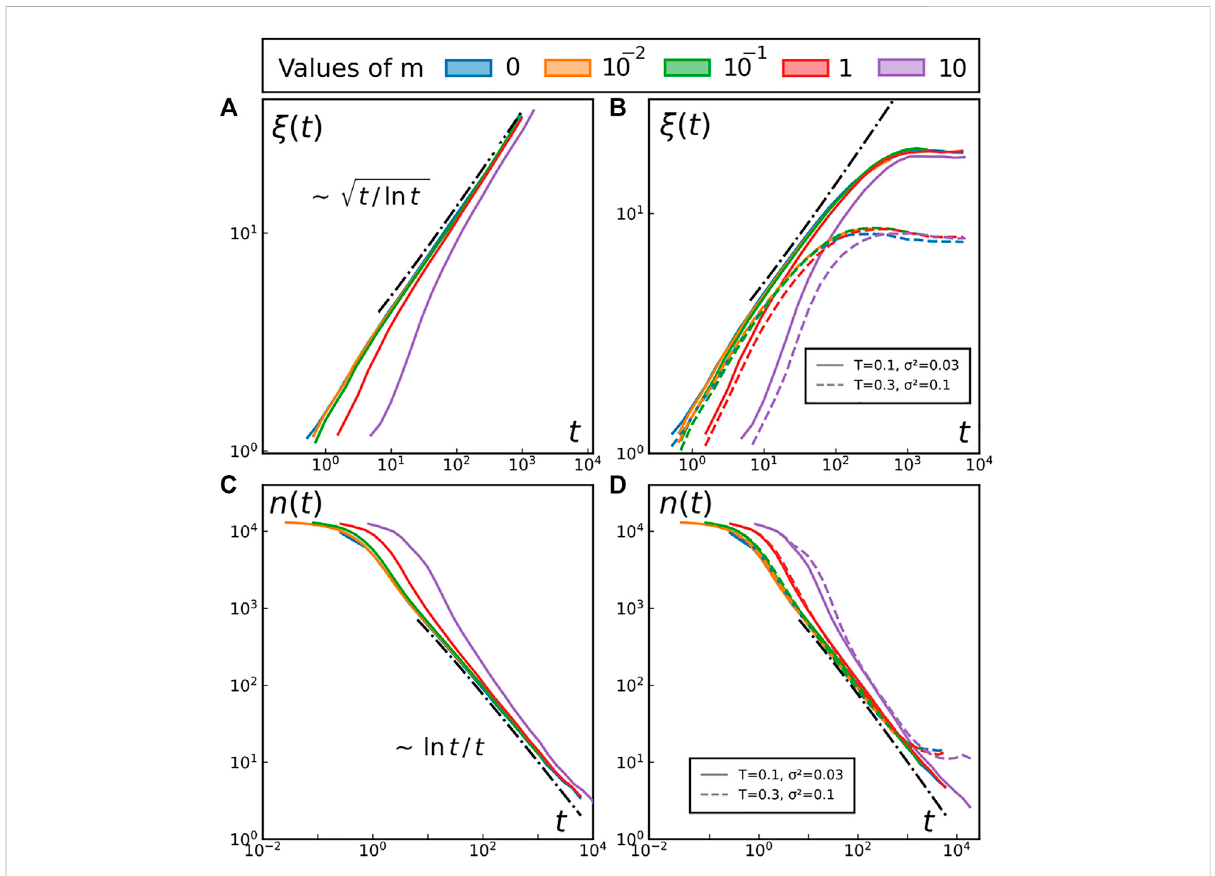
FIGURE 8 Relaxationfromaninitiallydisorderedstate.Differentcoloursrepresentdifferentinertia m forallfourpanels,asindicatedatthetopofthe fi gure. Top row: Time evolution of the correlation length ξ ( t ) for (A) the XY model at T = 0.2 and for (B) the driven system at the different values of T and σ . Bottomrow: Timeevolutionofthetotalnumberofdefects n ( t )for (C) theXYmodelat T =0.2andfor (D) thedrivensystematthedifferentvaluesof T and σ . We only display two sets of parameters for readability but we have reached the same conclusions for all the other tested parameters (distributed across the entire phase space). Left column: At equilibrium. Right column: